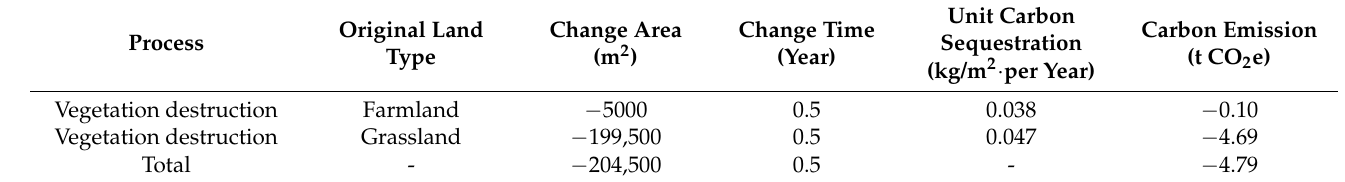
Table 7. Carbon sinks caused by vegetation destruction during the construction